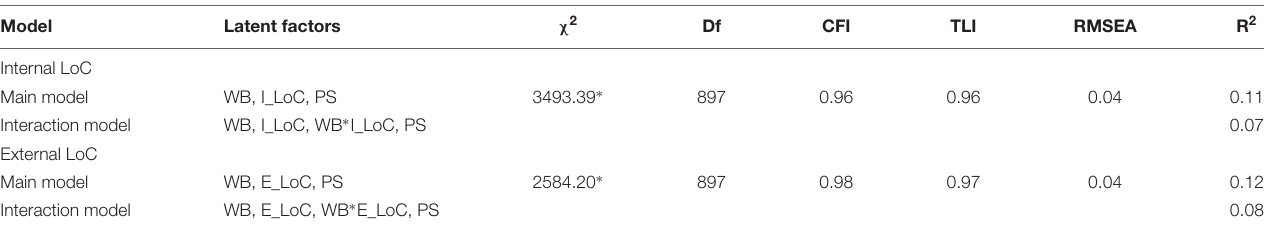
TABLE 4 | Fit statistics for the hypothesized